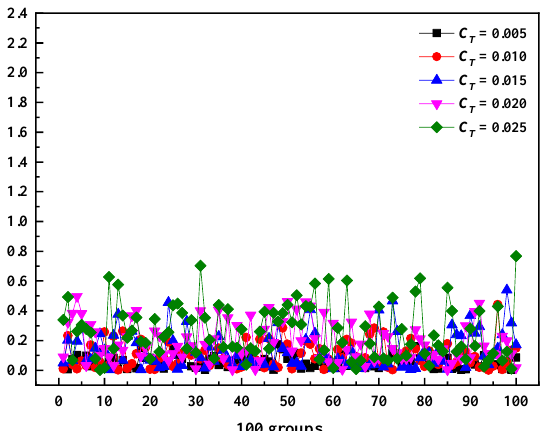
Figure 16. Center concentration deviation under the different relative standard deviations of tem- peratures at velocity 4.3 m/s.